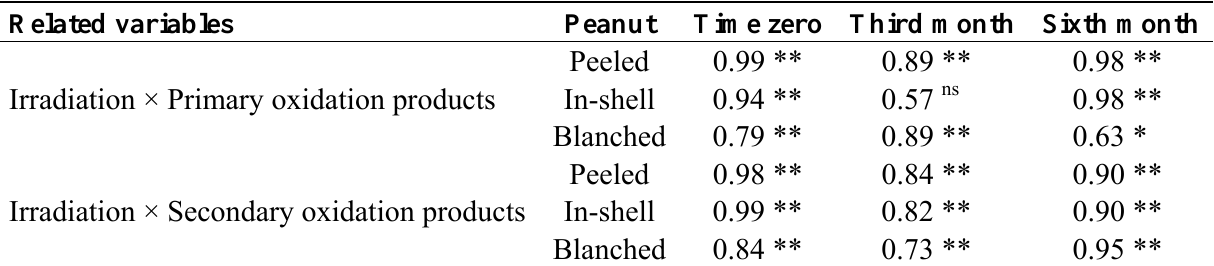
Table 9. Pearson’s correlation between gamma radiation and oxidation